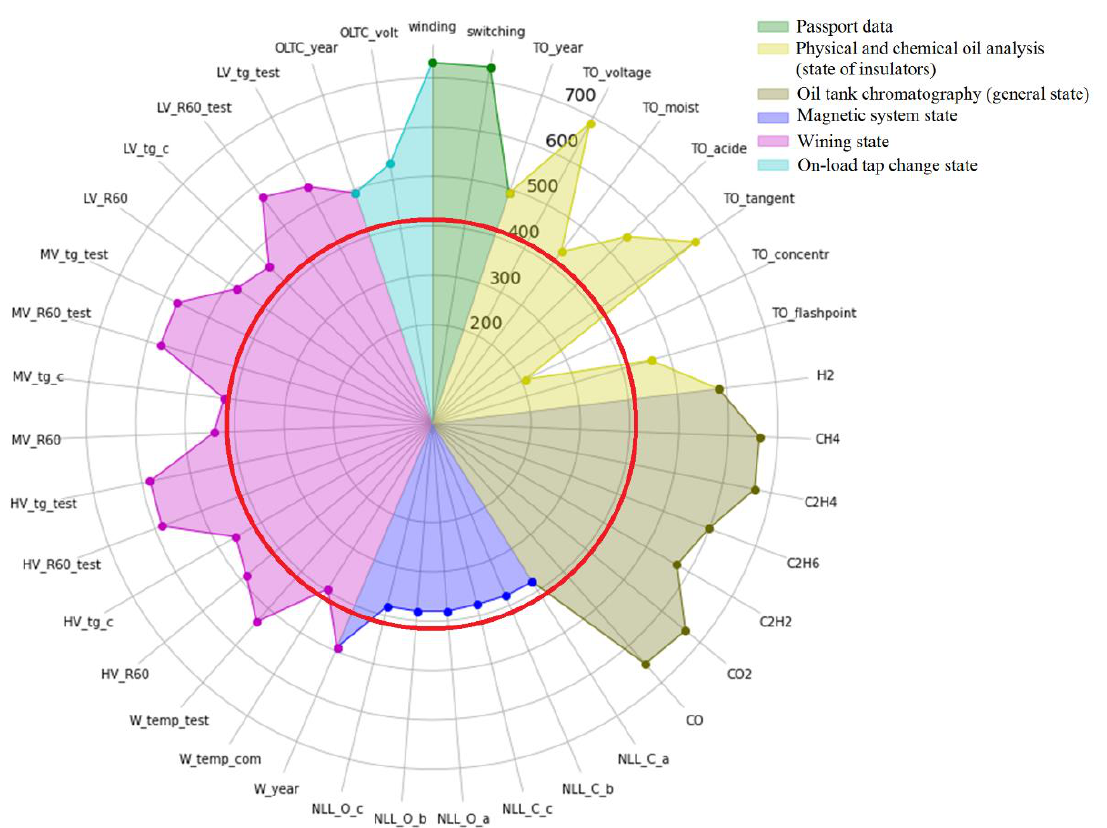
Figure 2. Data area diagram of the power transformer dataset after performing Steps 1 and 2 of the algorithm. the